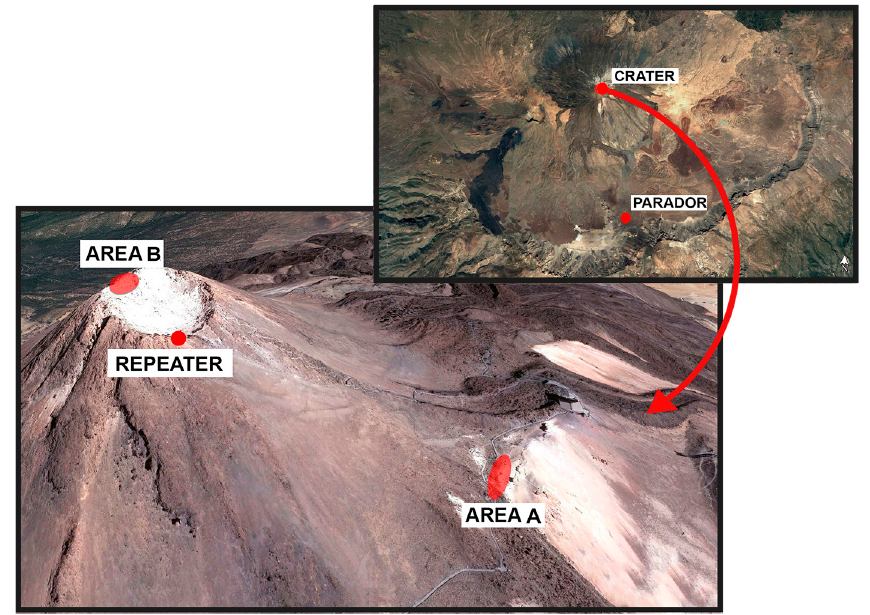
Figure 11. Wireless network configuration installed in Las Cañadas del Teide, Tenerife. Devices were deployed as follows: the gateway in the Parador, the repeater at the southern rim of Teide crater, and the eight thermometers on the summit part of Teide volcano (areas A and B).